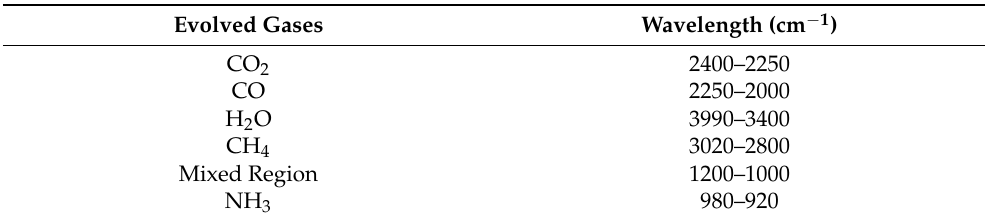
Table 1. Wavelength assignment for chemigrams of online